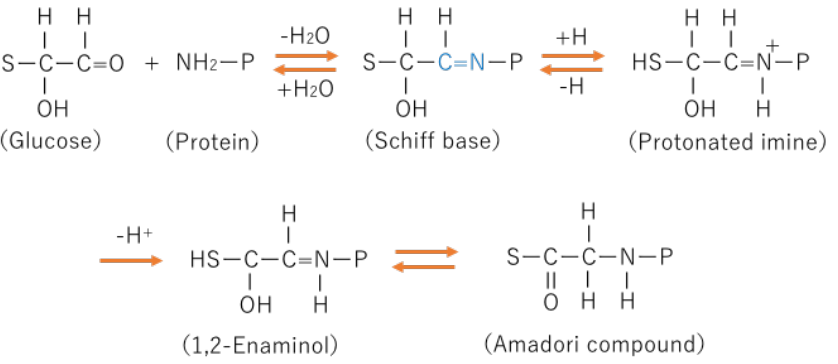
Figure 1. Initial step of the Maillard reaction. In the first step, a protein reacts with an amino acid, which results in the production of a Schiff base. The Schiff base is converted into an Amadori product by the Amadori rearrangement through a protonated imine and 1,2-enaminol formation. S: reducing sugar, P: protein.